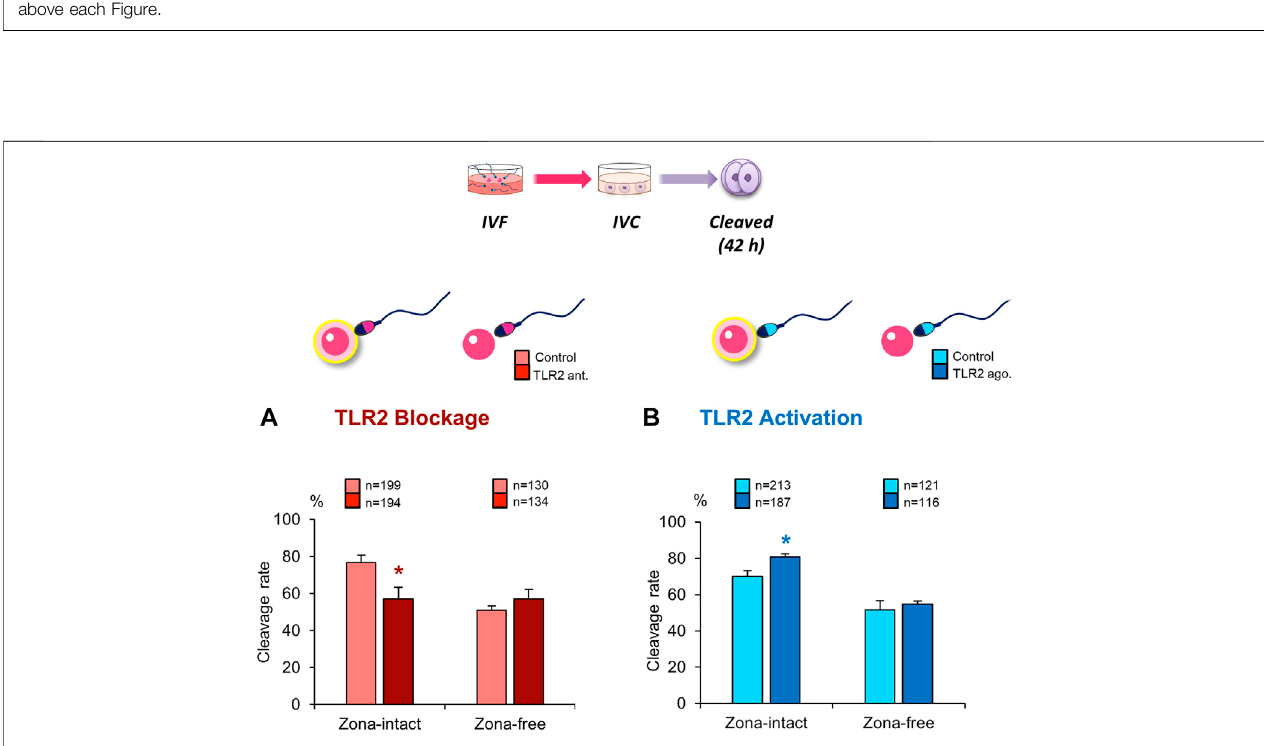
FIGURE 3 | Blockage/activation of sperm TLR2 suppressed/enhanced the cleavage rate in cumulus-free oocytes, but not in zona-free oocytes. Sperm were pre-treated by (A) TLR2 antagonist (100 µM) or (B) TLR2 agonist (100 ng ml − 1 ) for 30 min, washed, and co-cultured with cumulus-free (zona-intact) and zona-free oocytes. Percentage of fertilized oocytes observed after 42 h post insemination. Data reported as means ± S.E.M. Different superscript asterisks denote a signi fi cant difference ( p < 0.05). The number of presumptive zygotes for each treatment group (from three independent experiments) is speci fi ed above each